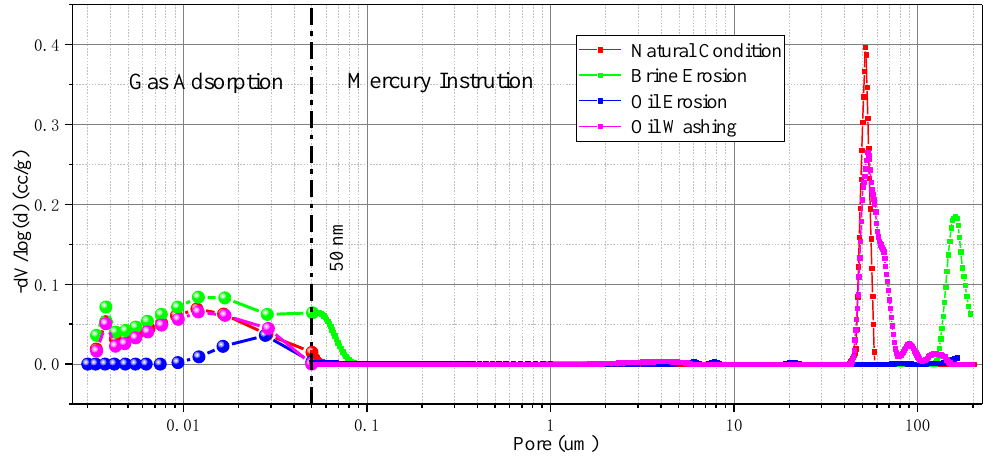
Figure 13. The total pore size distribution of interlayer samples under different conditions.